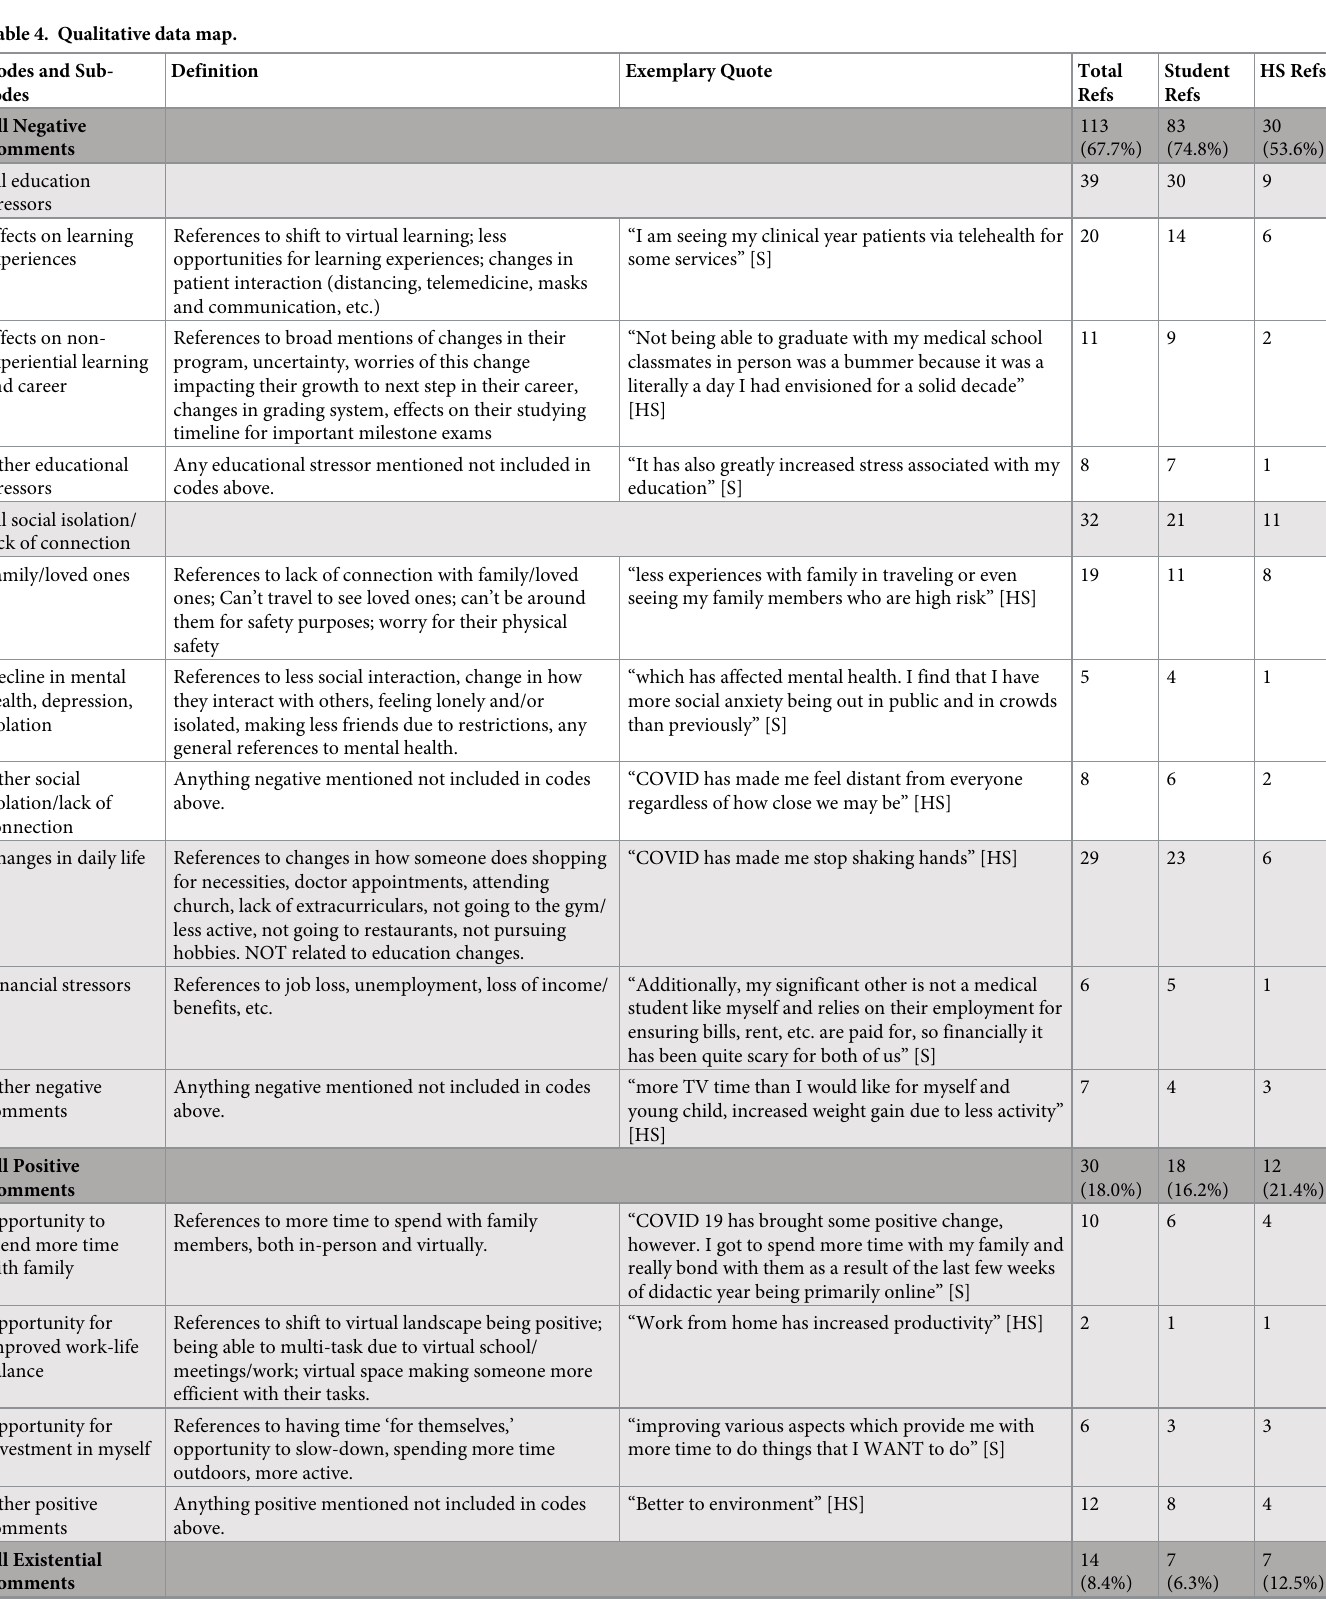
Table 4. Qualitative data